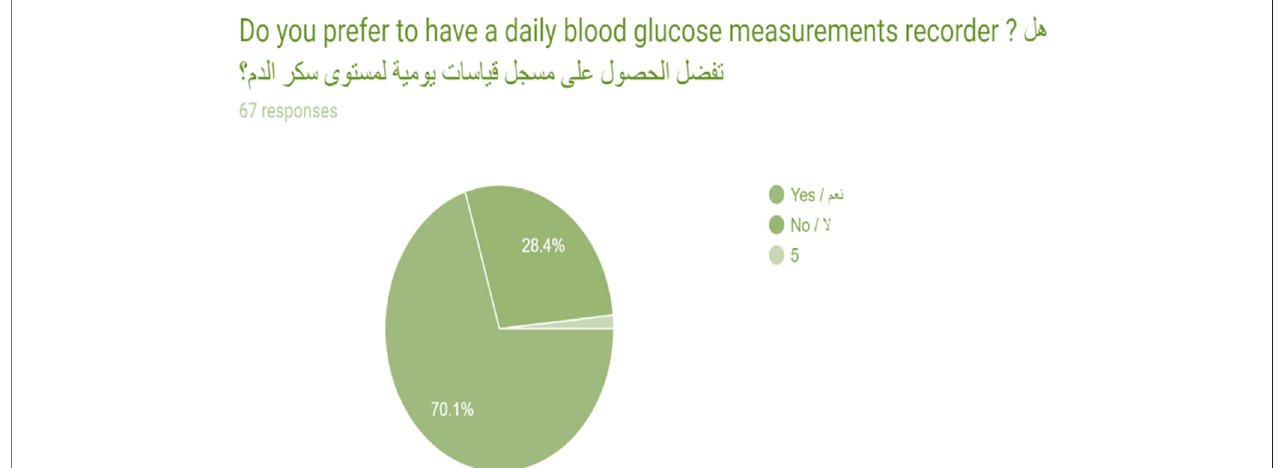
FIGURE 4 | Patient ’ s questionnaire results.